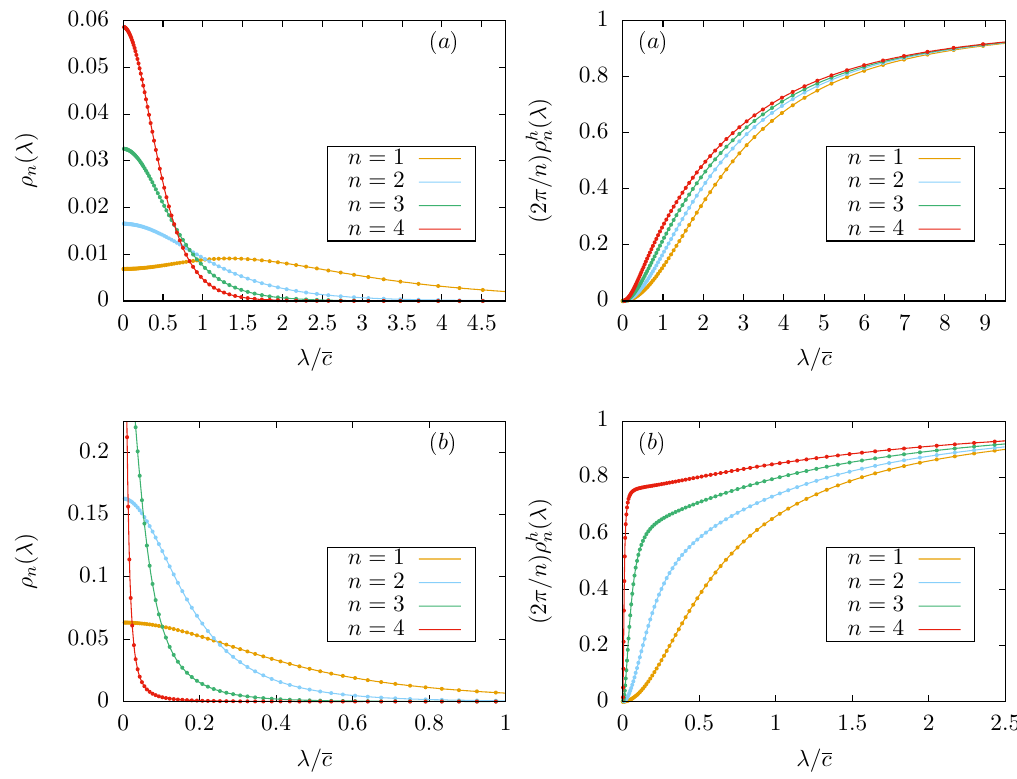
( λ ) and ( 2 π/ n ) ρ h ( λ ) for n -string solutions with Figure 1: Rapidity distribution functions ρ n n n ≤ 4. The final value of the interaction is chosen as ( a ) γ = 0.25 and ( b ) γ = 2.5. The dots correspond to the numerical solution discussed in section 5.1, while solid lines correspond to the analytical solution presented in section 5.3. The functions are shown for λ > 0 (being symmetric with respect to λ = 0) and have been rescaled for presentational purposes. Note that the rescaling factors for the hole distributions are determined by their asymptotic values, ρ h ( λ ) → n / 2 π as λ → ∞ n